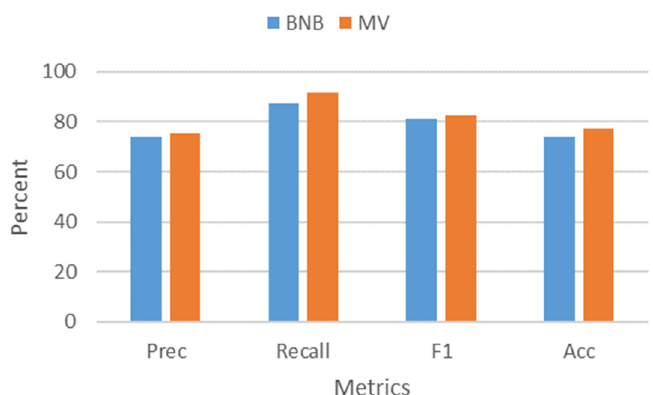
Figure 5. Performance of BNB vs. MV.